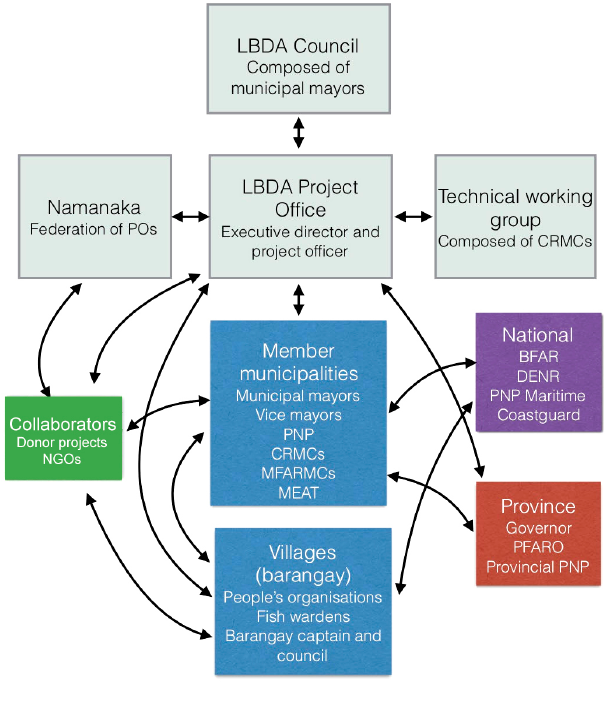
Fig. 2. Key actors involved in an ecosystem approach to fisheries management in Lanuza Bay (Fortnam 2017). BFAR = Bureau of Fisheries and Aquatic Resources, CRMC